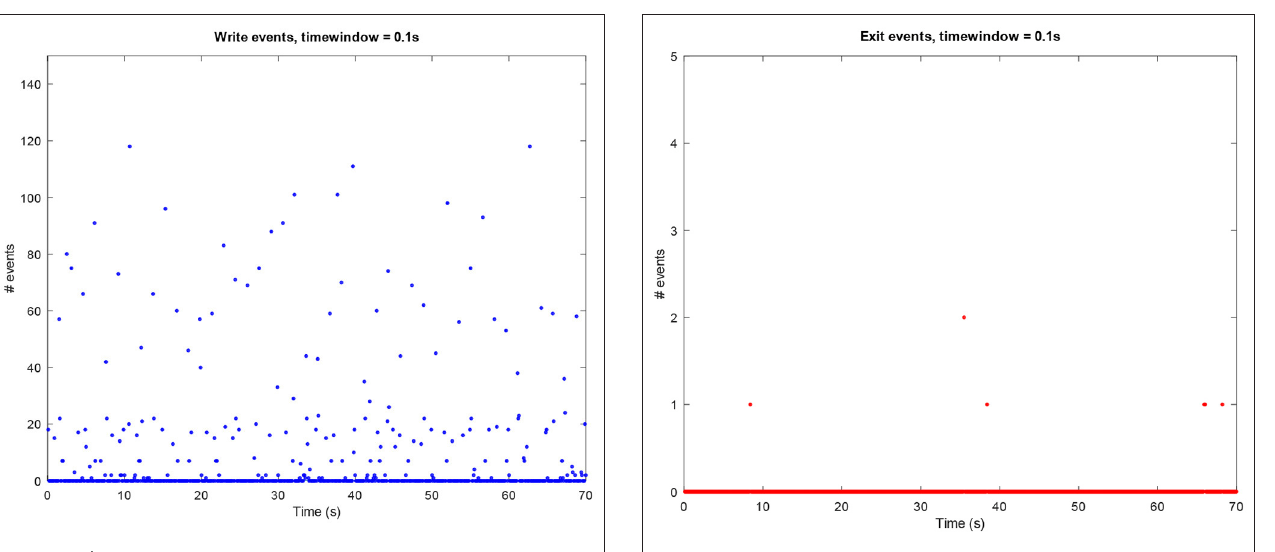
FIGURE 4 | Amount of write events per window of time (0.1 s ) in an idle mode process.